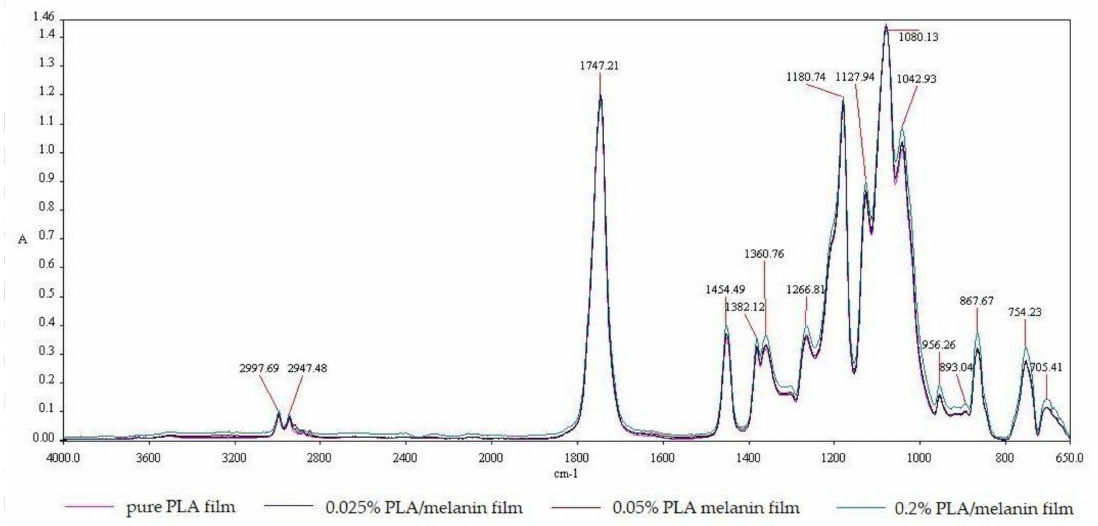
Figure 3. The FT-IR spectra of pure PLA and PLA/melanin modified films.